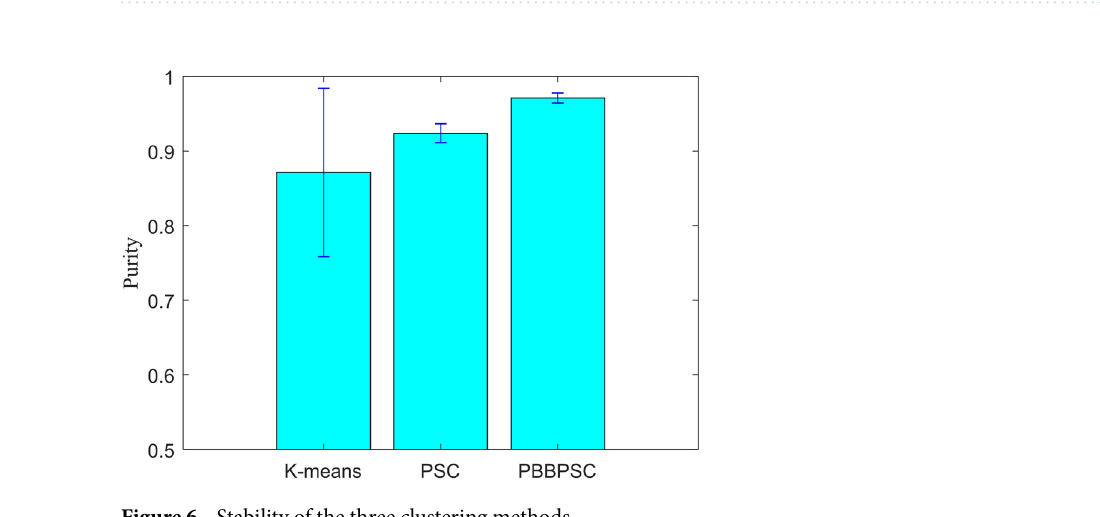
Figure 6. Stability of the three clustering